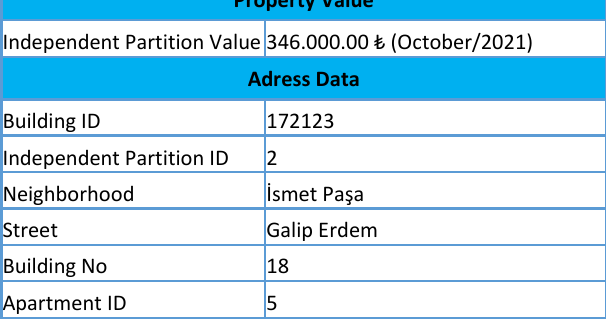
Table 1. Property information